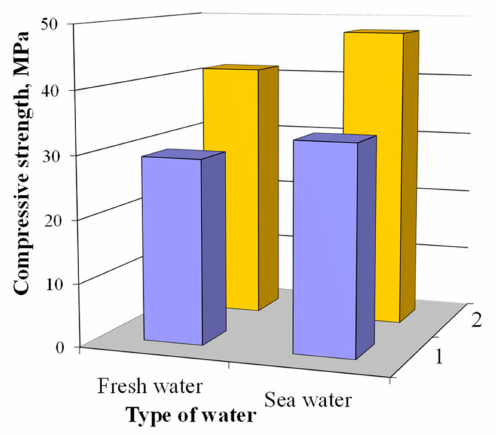
Figure 10. The 28-day compressive strength of the plasticized concrete based on blast furnace cement containing calcium aluminate cement and clinoptilolite in combination with 1—Na 2 CO 3 and 2—Na 2 SiO 3 · 5H 2